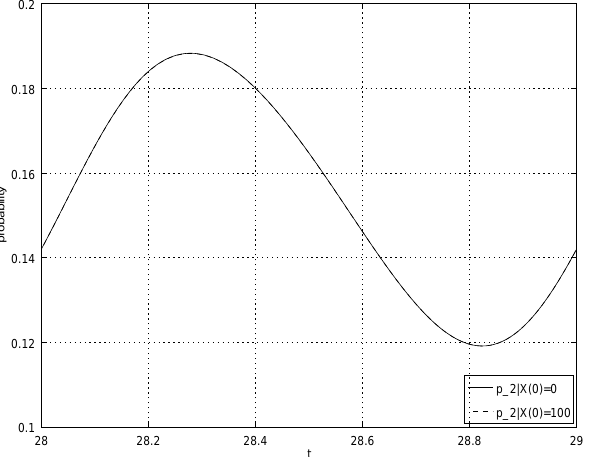
Figure 3. Probability p 2 ( t ) for t ∈ [ 0,28 ] and initial conditions X ( 0 ) = 0 and X ( 0 ) = 100; this figure shows the rate of convergence.